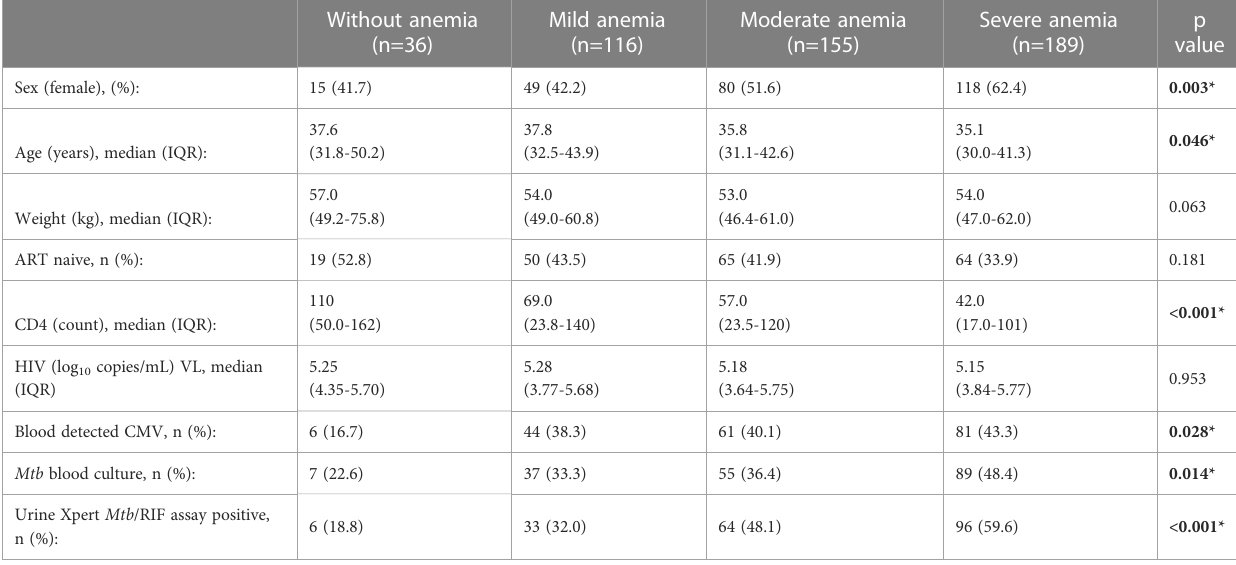
TABLE 1 Clinical characteristics of HIV-TB patients according